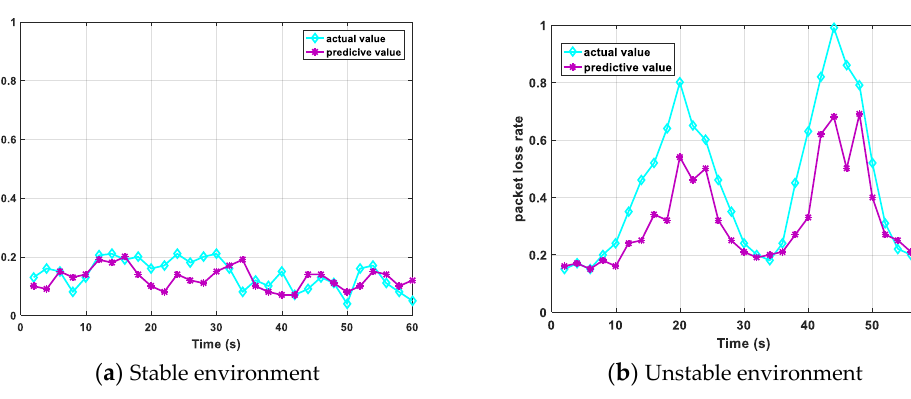
Figure 11. Predictive e ff ect of packet loss